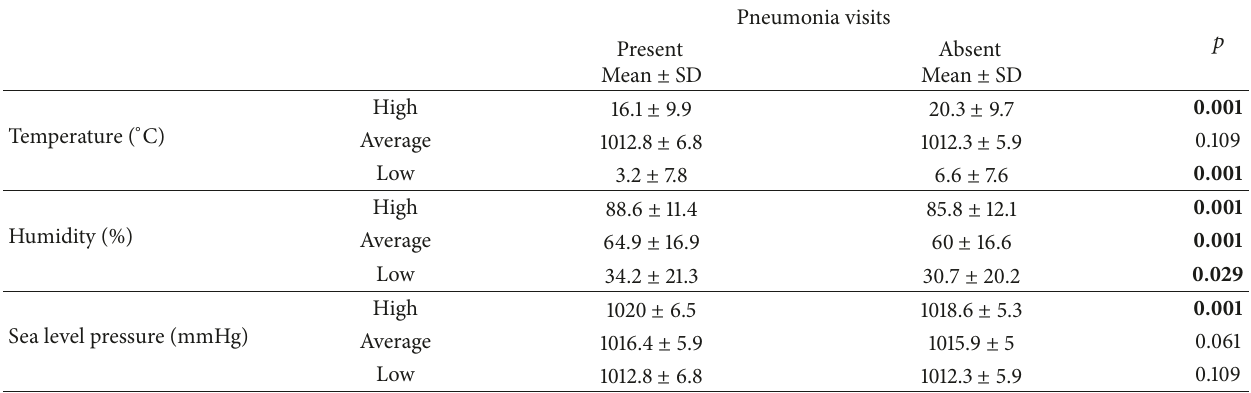
Table 3: Relationship between the pneumonia visits and temperature parameters.